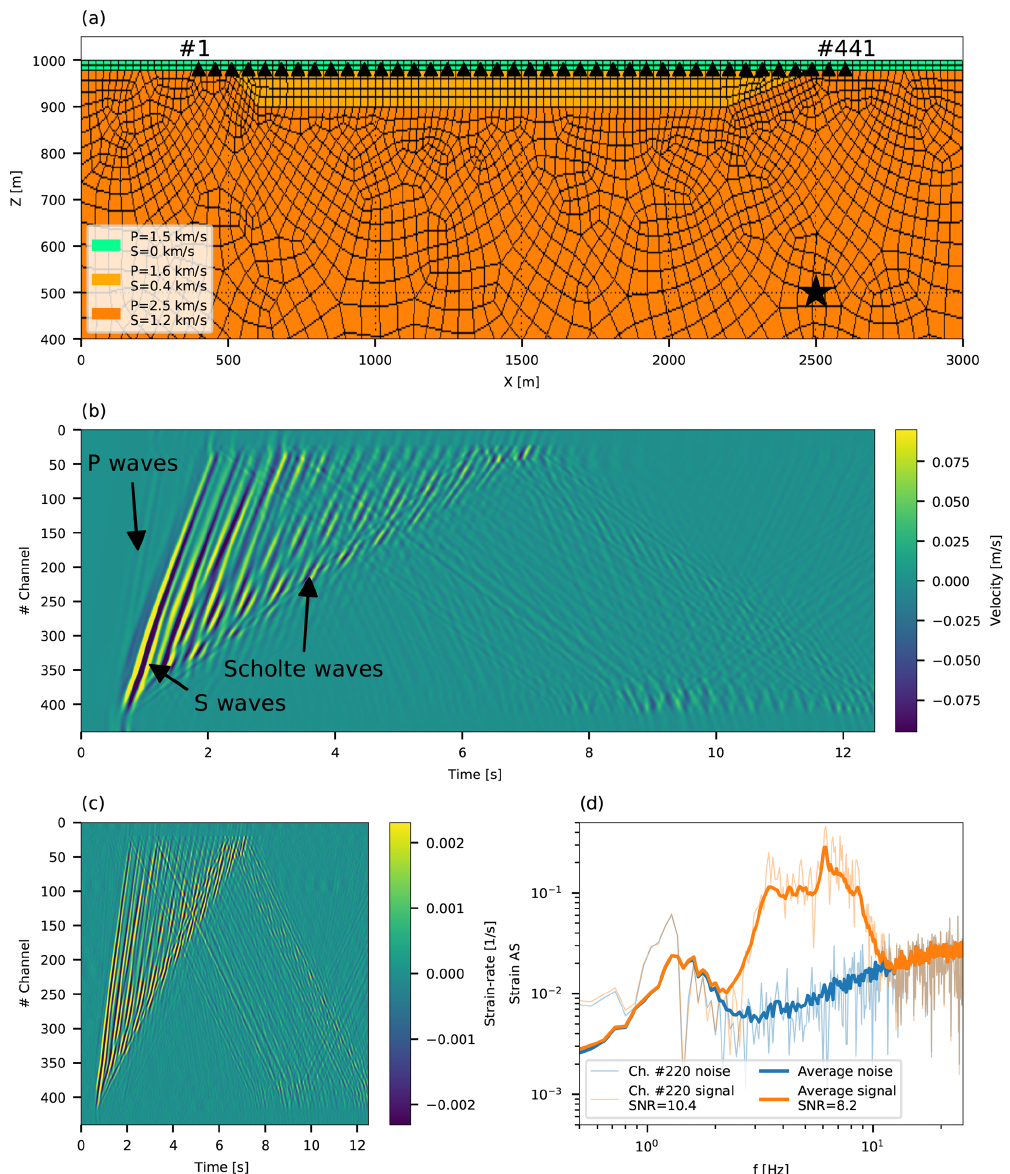
Figure 2. Velocity model and simulated velocity, strain rate and noise data. Panel (a) shows the unstructured 2D numerical mesh: the double-couple source location is indicated by a black star and sensors are indicated by black triangles, equally spaced between X = 400m to X = 2600m (first and last sensor channel numbers are indicated). Panel (b) shows simulated velocity waveforms, with visible P waves, S waves and Scholte waves. Panel (c) shows strain-rate signals added with ambient noise. Panel (d) shows simulated strain rate and noise signals. Noise curves for channel no. 220 and averaged for all channels are indicated by semi-transparent and solid blue curves, respectively. Signals added with noise for channel no. 220 and averaged for all channels are indicated by semi-transparent and solid orange curves, respectively. SNR values are reported in the